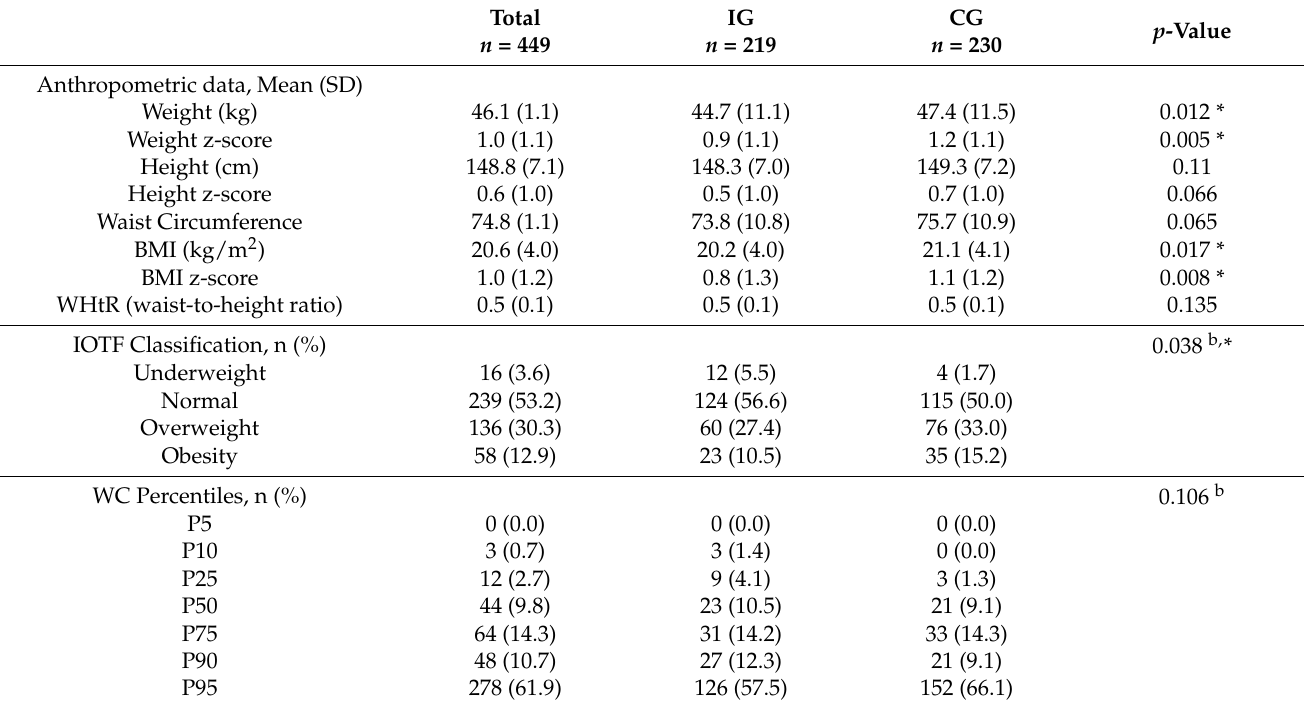
Table 2. Anthropometric measures of intervention group (IG) and control group (CG) at